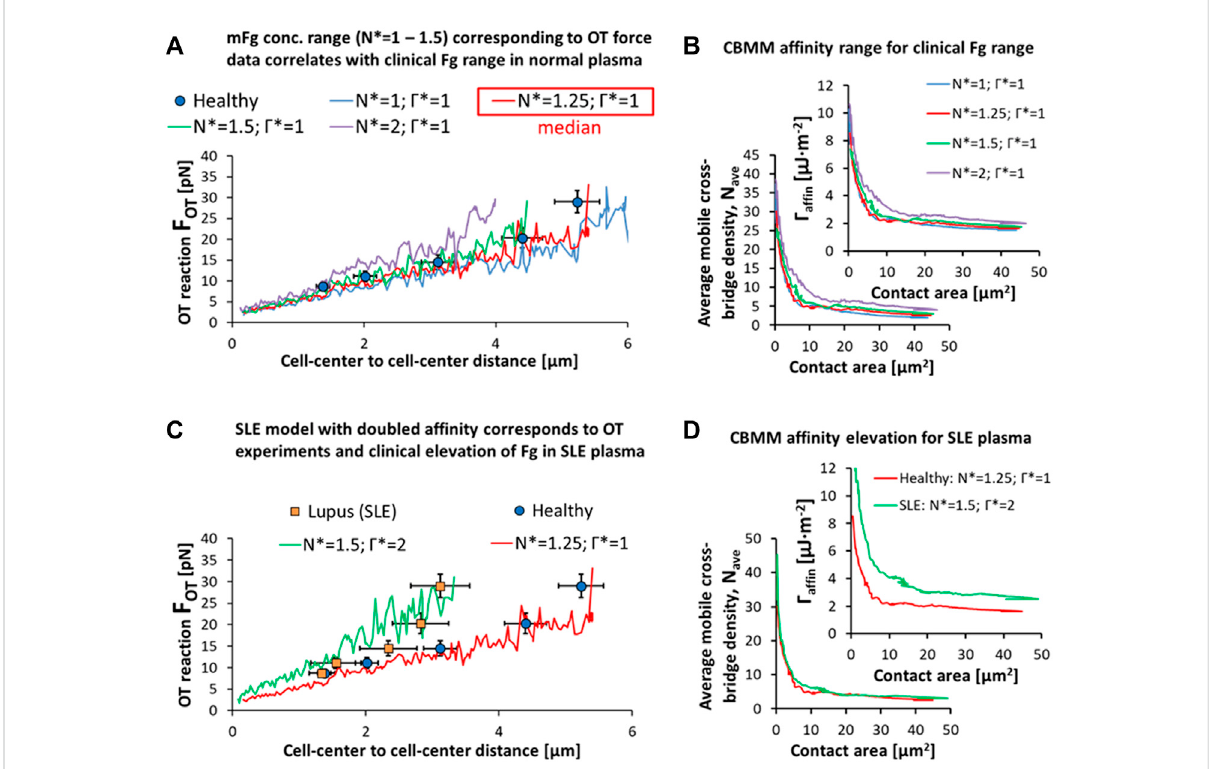
FIGURE 7 Pathophysiological representations of RBC doublet disaggregation. (A,B) Variation in the OT experimental data can be explained in the CBMM by variation in the surface adsorption of Fg in accordance with the clinical variation in Fg levels in plasma from healthy samples. (C,D) SLE samples results in OT can be explained by a dual-effect of elevation in surface adsorbed Fg (N* = 1.25 for median level in healthy RBCs and plasma to N* = 1.5formedianlevelinSLERBCsinSLEplasma)andanincreaseinmFgmediatedaf fi nity( Γ *=1forhealthyto Γ *=2inSLE).Simulationmoviesof the parametric variations in N* and Γ * can be seen in